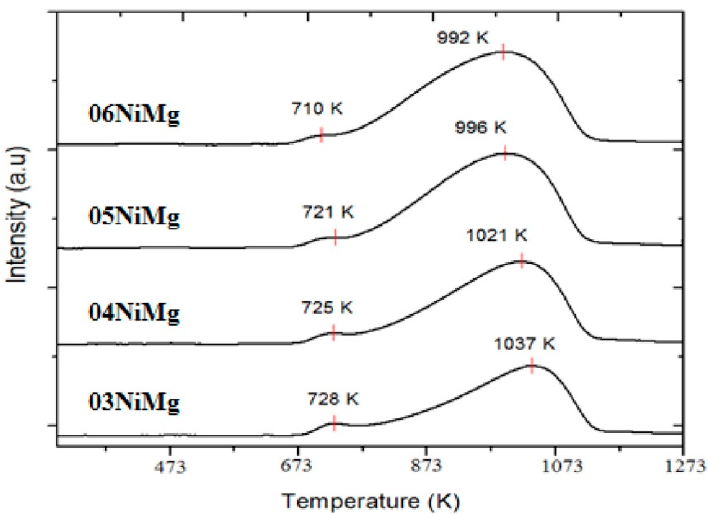
Figure 14. TPR analyses of the calcined hydrotalcite-like precursors (xNiMg) with different Ni loading (x is the molar ratio of Ni 2+ /Mg 2+ . Reprinted with permission from Ref. [199]. Copyright 2022 Elsevier.